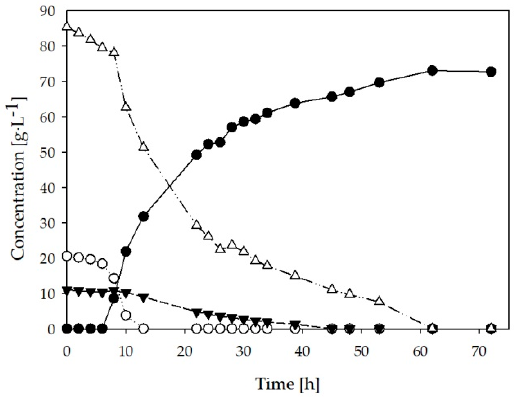
Figure 3. B. coagulans fermentations carried out in pilot scale (50 L) with SSJ as sole carbon and nutrient source. Fermentative production of lactic acid ( ● ) and consumption of glucose ( ○ ); fructose ▼ ; disaccharides ( ∆ ).